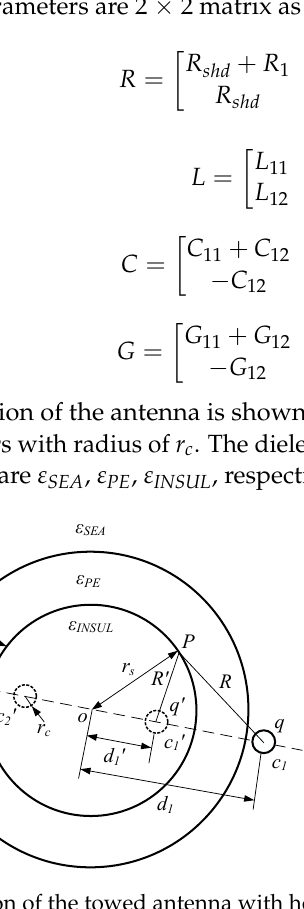
Figure 3. Cross-section of the towed antenna with helix coil sensors. The induced charge q on the sphere can be equated with a mirror image charge q’ inside the conductor sphere. The mirror charge is located on the line connecting the point charge to the center of the sphere at a distance of d 1 ’ . Then, the potential equation [18] can be expressed as